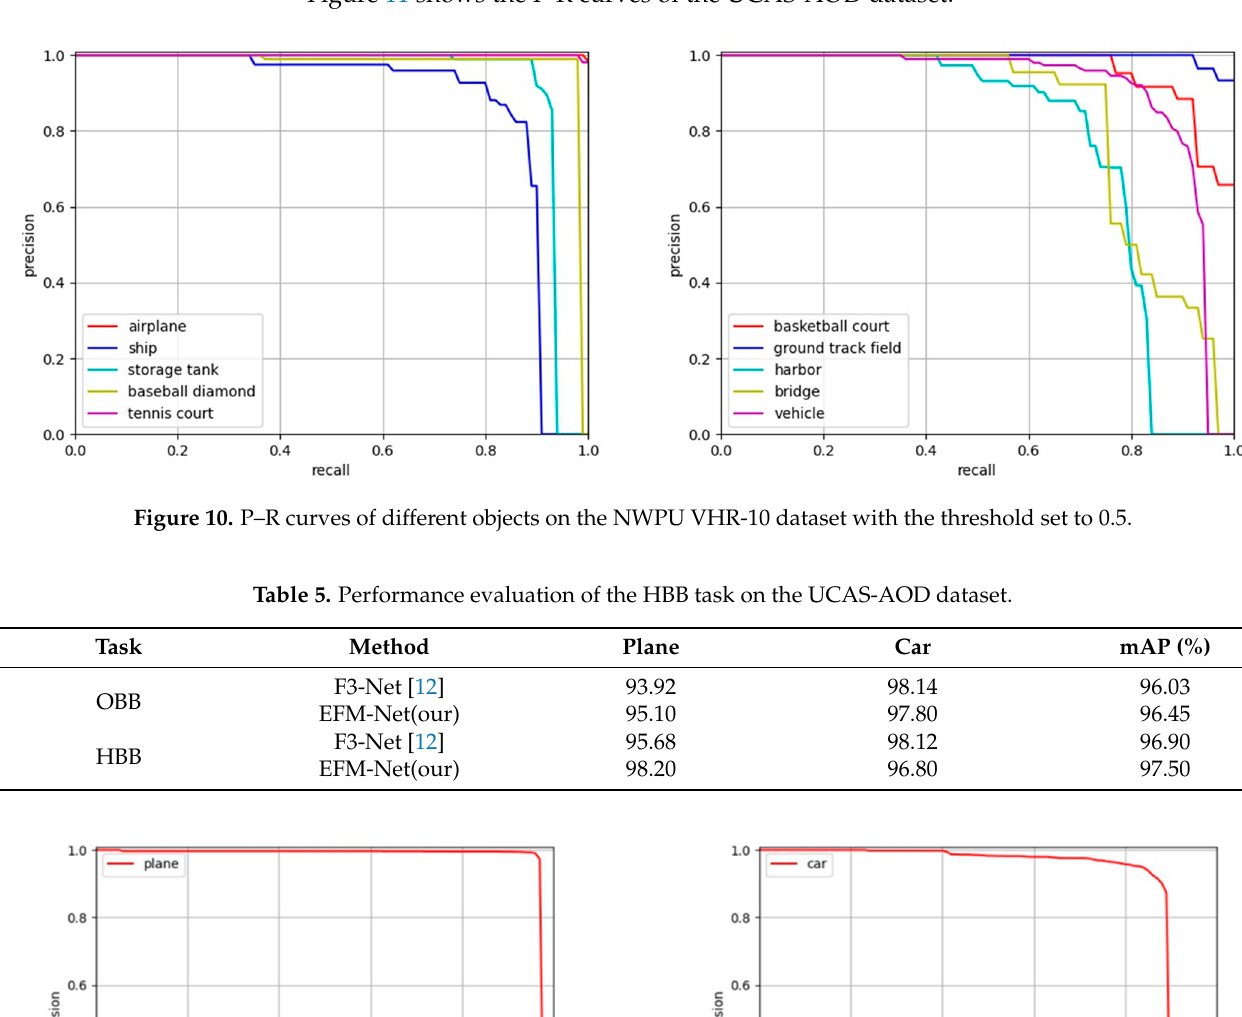
Table 4. Performance evaluation of the HBB task on the NWPU VHR-10 dataset.